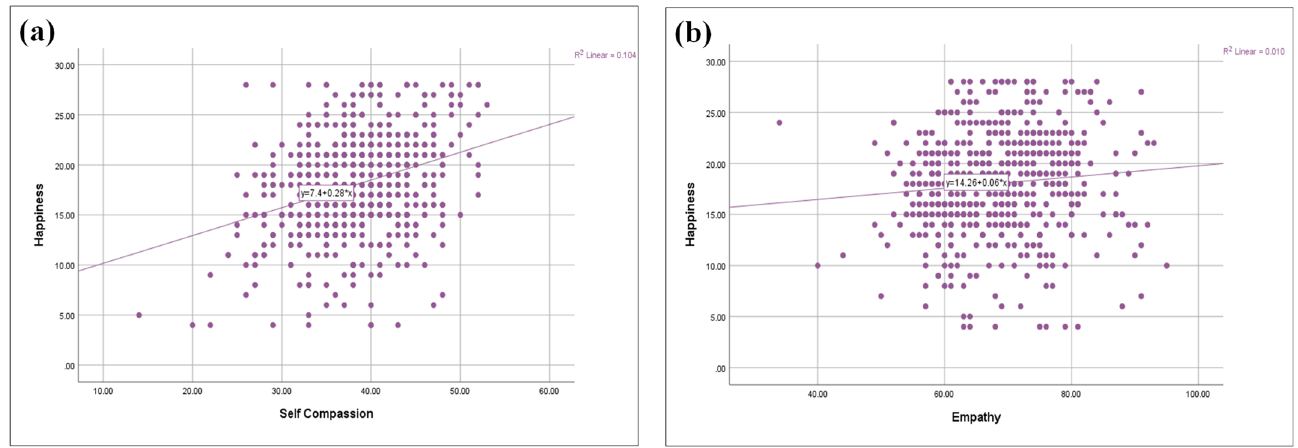
Figure 2. Regression plot of ( a ) self-compassion and happiness and ( b ) empathy and happiness.